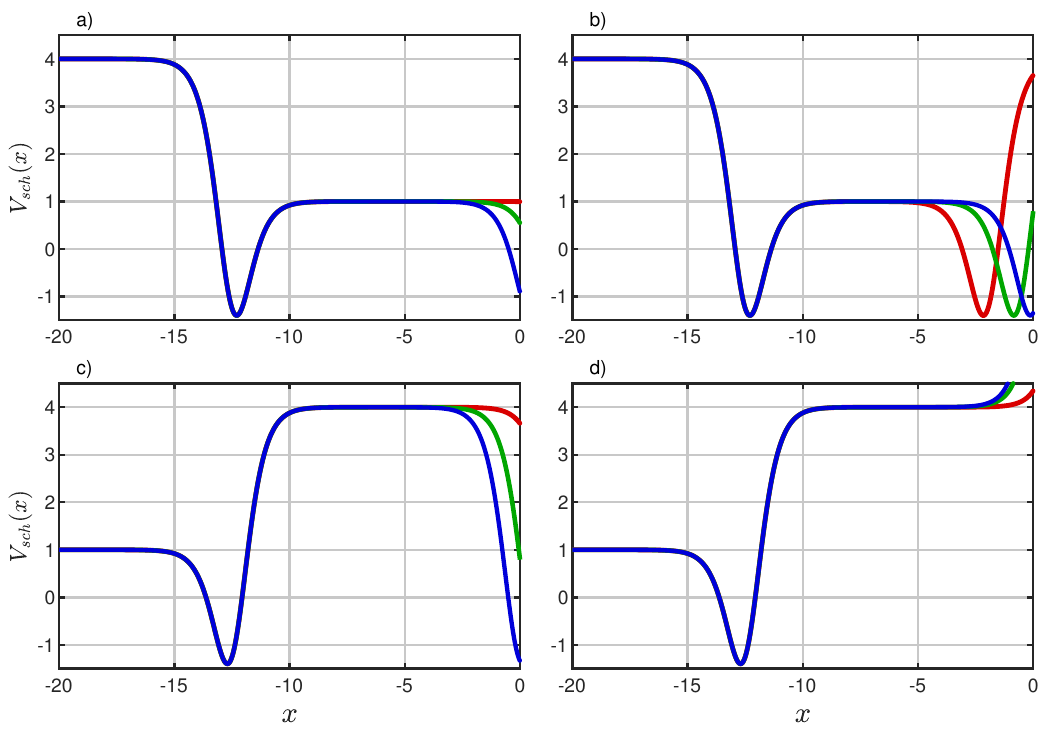
Figure 6 . Schr¨odinger-like potential for static configurations: a) Φ 2+ ( x a ) + φ 2 ( x ) c) Φ 1+ ( x (red), H = 0 . 50 H m (green) and | |